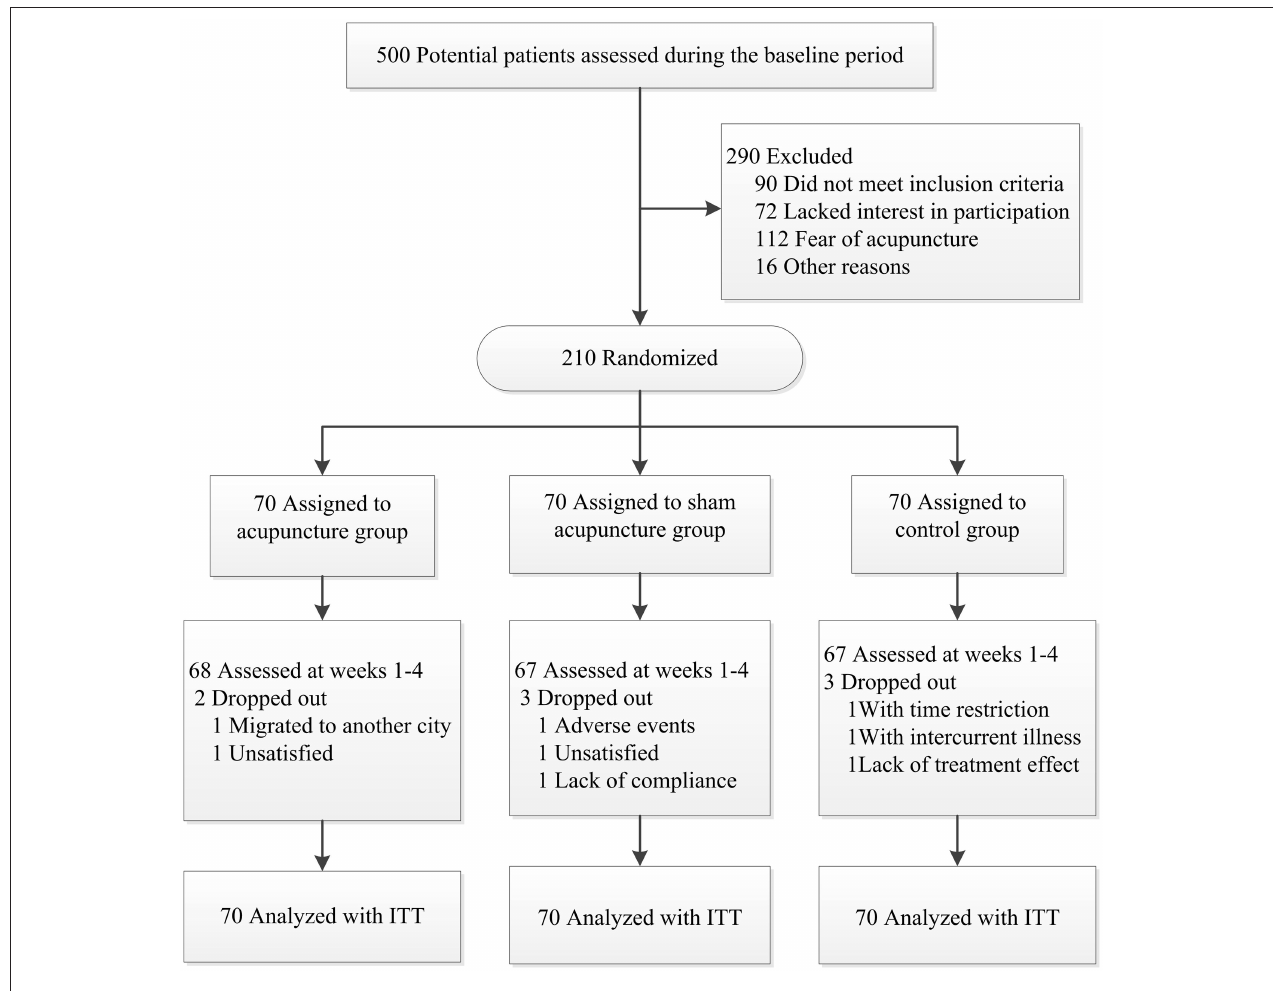
FIGURE 1 | Flowchart of the screening, enrollment, and randomization.